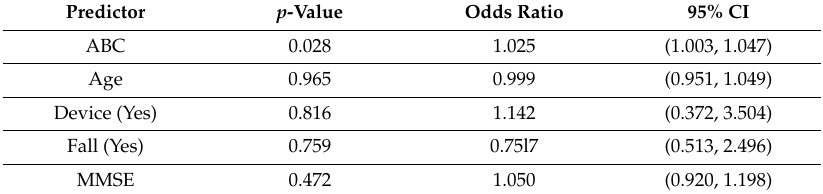
Table 3. Logistic regression analysis of improvement on 4SBT from Initial Visit to Follow-up Visit